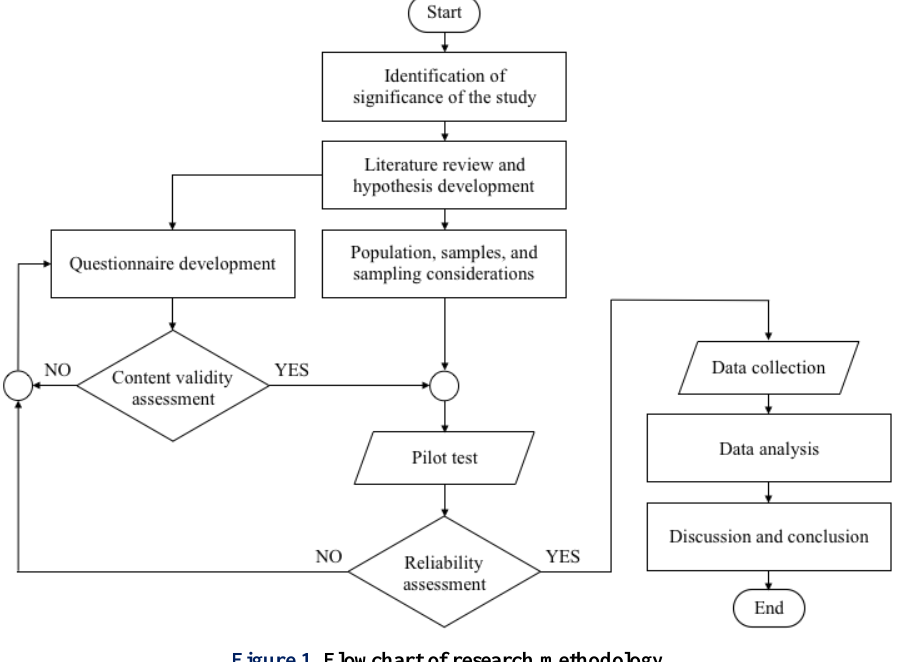
Figure 1. Flowchart of research